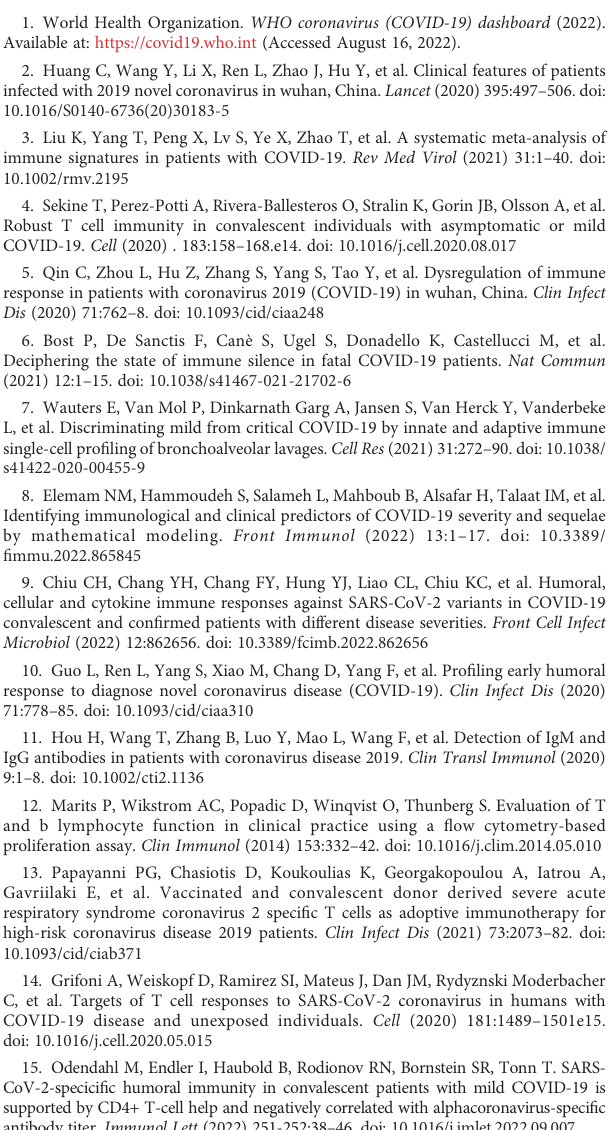
SUPPLEMENTARY FIGURE 1 (A) Comparison of CD3+, CD4+ and CD8+ blasts/µl of blood between healthy controls (control) (grey dots; n=30), seropositive patients (purple dots; n=59) and seronegative patients (green dots; n=26) after stimulation with common cold coronavirus HCoV-229E and (B) CMV using the FASCIA assay. Each dot represents an individual. Median and IQR are shown. The Mann – Whitney U test was used. *<0.05, **<0.01,